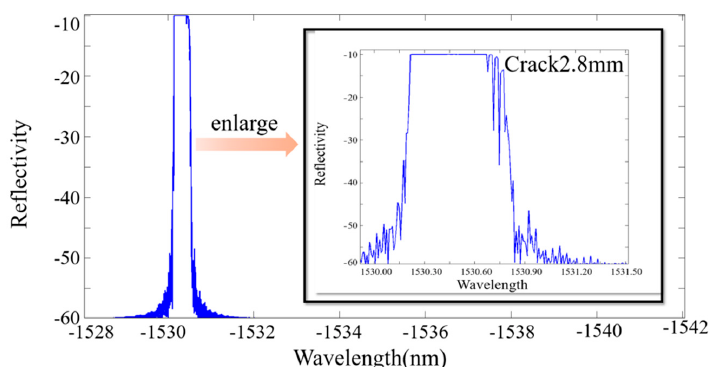
Figure 14. The simulated reflection intensity of a crack with a length of 2.8 mm.